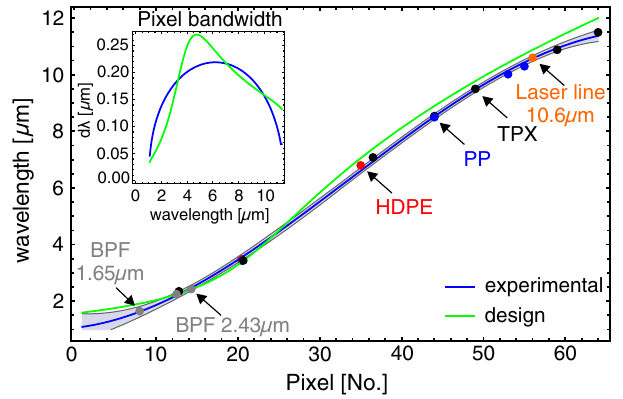
FIG. 12. Wavelength calibration of the MCT detector: The blue solid line indicates a third-order polynomial fit, with the light blue band representing the 3 σ confidence interval of the